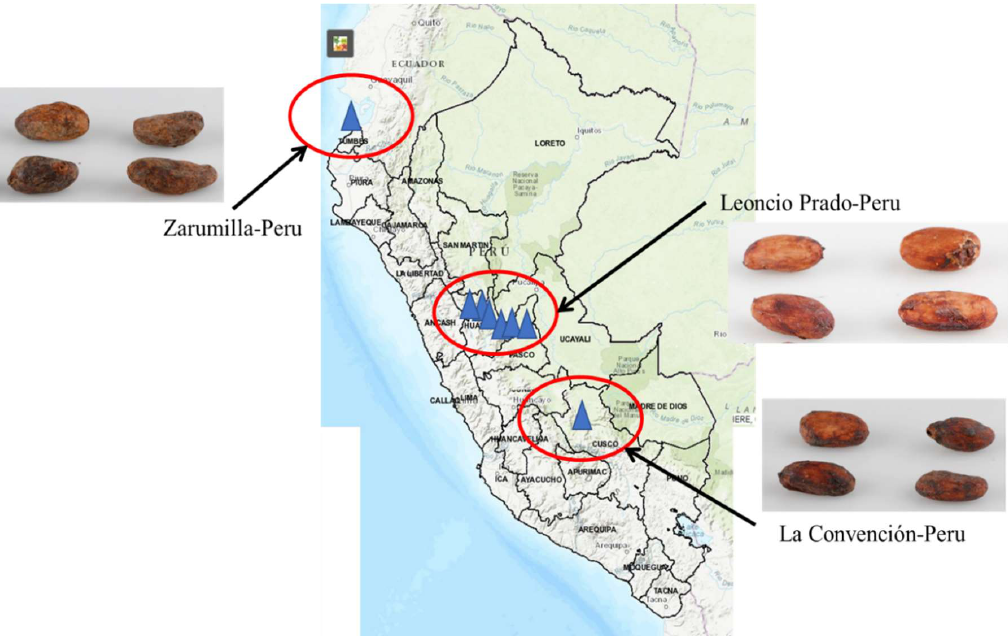
Figure 4. Different origins of cacao samples in Peru. Figure 4. Di ff erent origins of cacao samples in